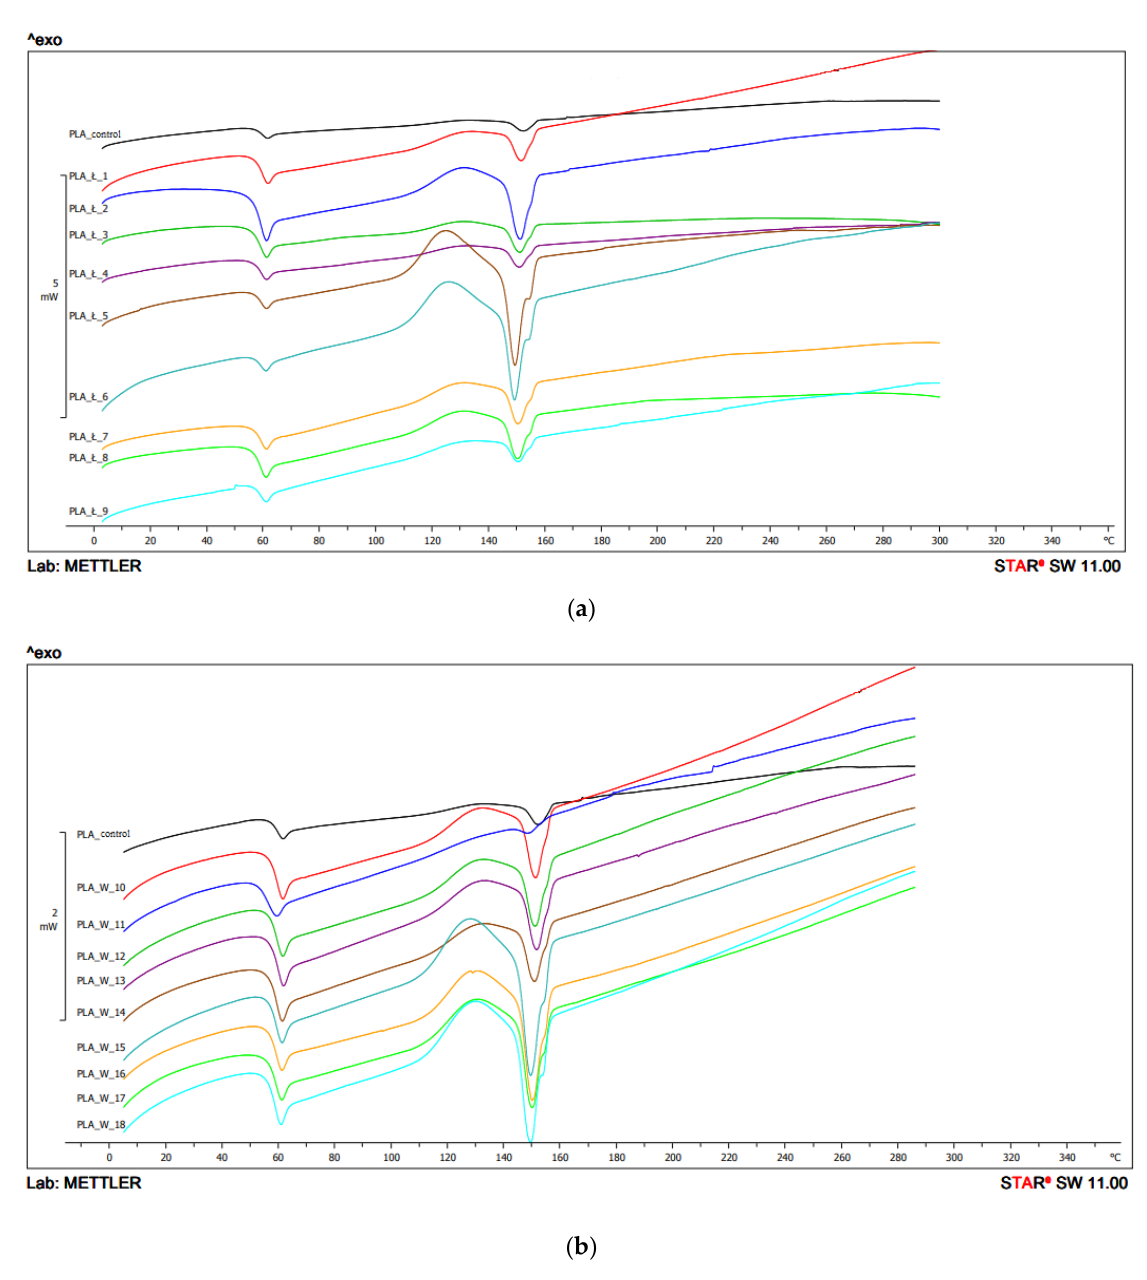
Figure 6. DSC thermograms’ heating analysis 2: ( a ) configuration 1; ( b ) configuration of 2. Abbreviations: as in Figure 5.